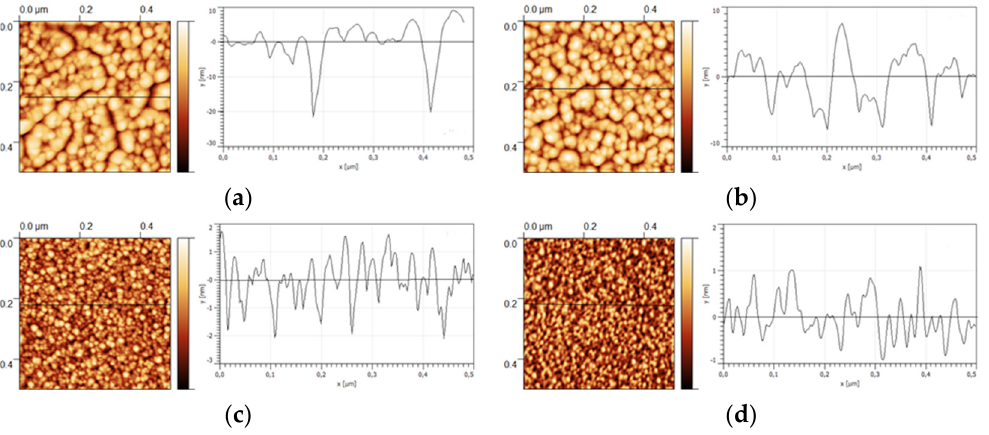
Figure 2. AFM images for Au NP arrays with different average thickness d , Au NP diameters D , pore sizes range r: ( a ) d = 84.5 nm, D = 25 nm, r = (30 ÷ 2) nm; ( b ) d = 35.5 nm, D = 25 nm, r = (40 ÷ 2) nm; ( c ) d = 15.2 nm, D = 9 nm, r = (14 ÷ 2) nm; ( d ) d = 5 nm, D = 7 nm, r = (18 ÷ 2) nm. The line profiles in each AFM image represent the height information along the